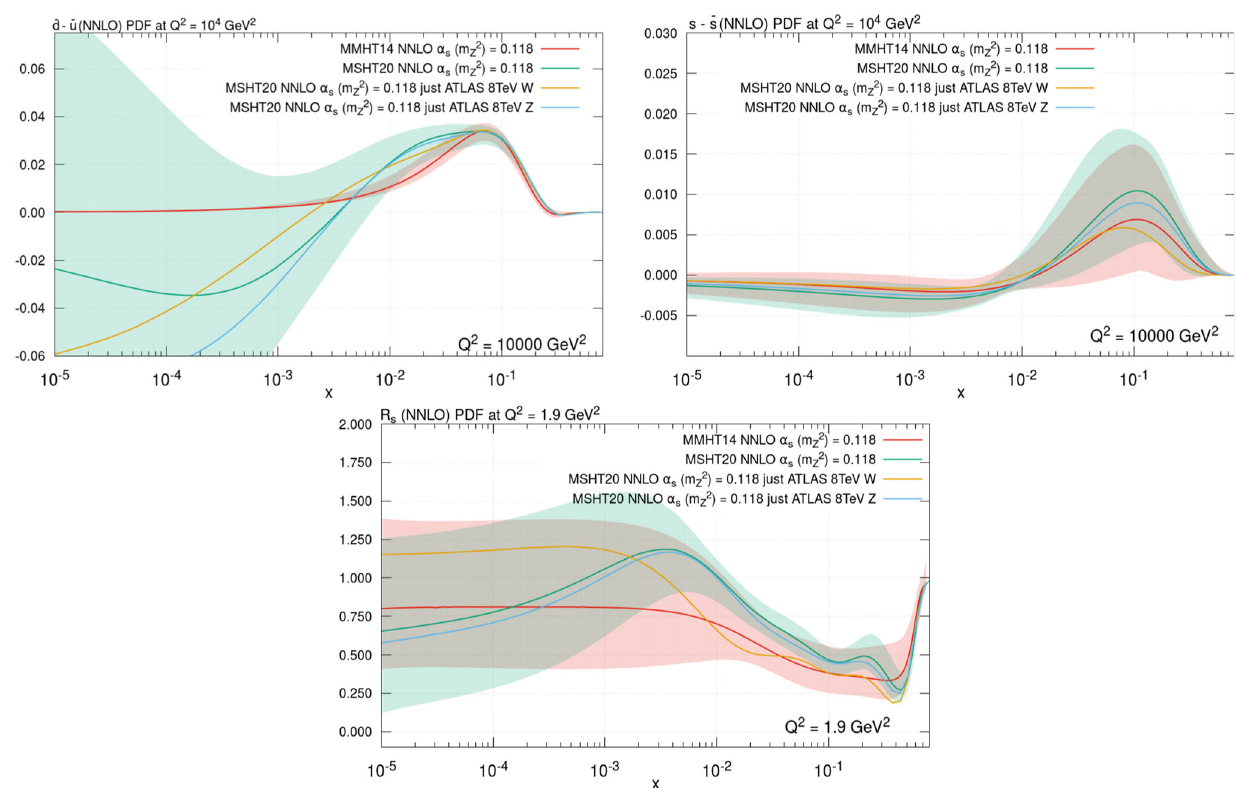
Fig. 66 As in Fig. 65, but showing the effects of removing separately just the ATLAS 8 TeV W or the Z data set